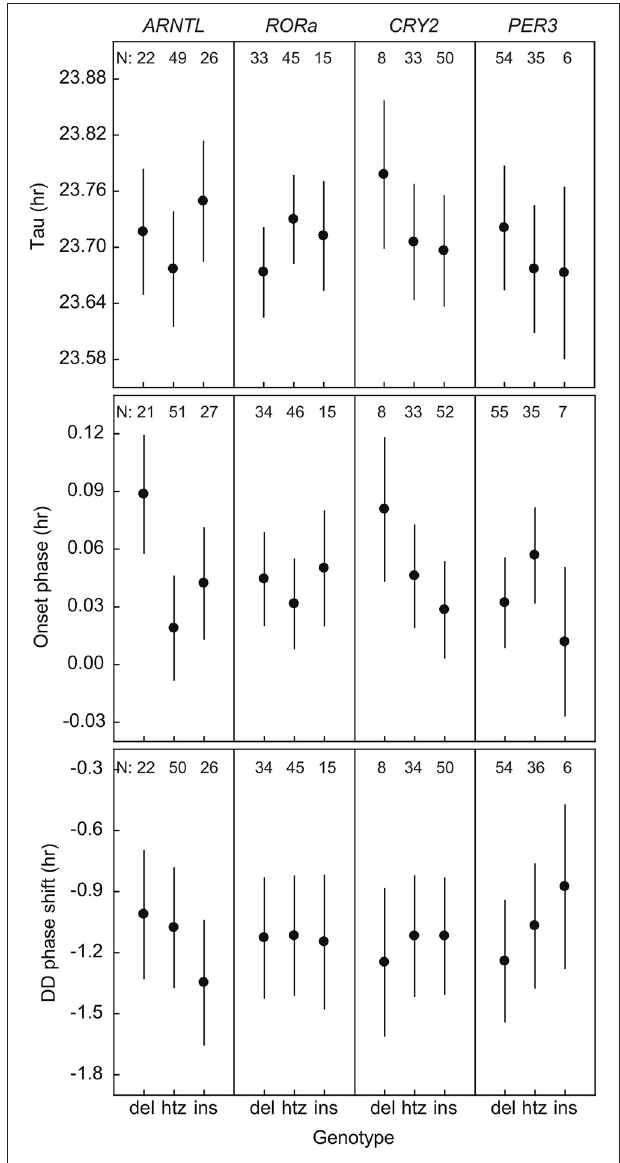
FIGURE 1 | Three phenotypic traits of rhythmicity plotted against the three genotypes (deletion, heterozygote, insertion) of the four candidate genes. Plotted values are estimated means standard error from the statistical ± model. N indicates the number of